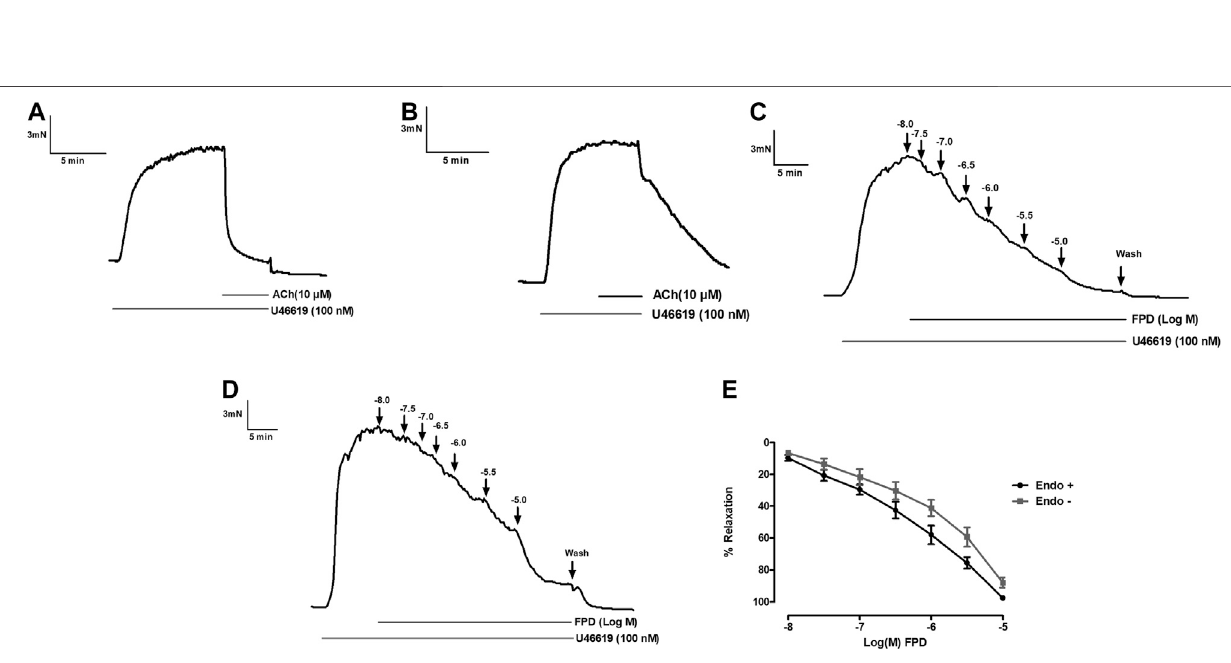
Frontiers in Pharmacology |